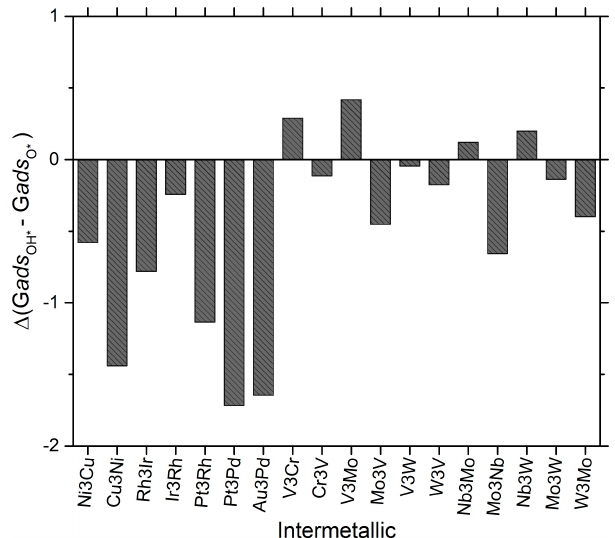
Figure 5. A plot of the free energy of formation for the hydrogenation of O* to OH* is given for some of the candidate materials studied in this work. For this plot, the data given shows the difference in free energy of the lowest energy site of OH* and the lowest energy site of O* on a given MDG NP. This is in the spirit of the Volcano Plot analysis previously identified in the literature [5]. In the formalism of this manuscript, negative sign convention in this plot denotes exergonic reaction steps. Units of the plot are given as ev/mol.